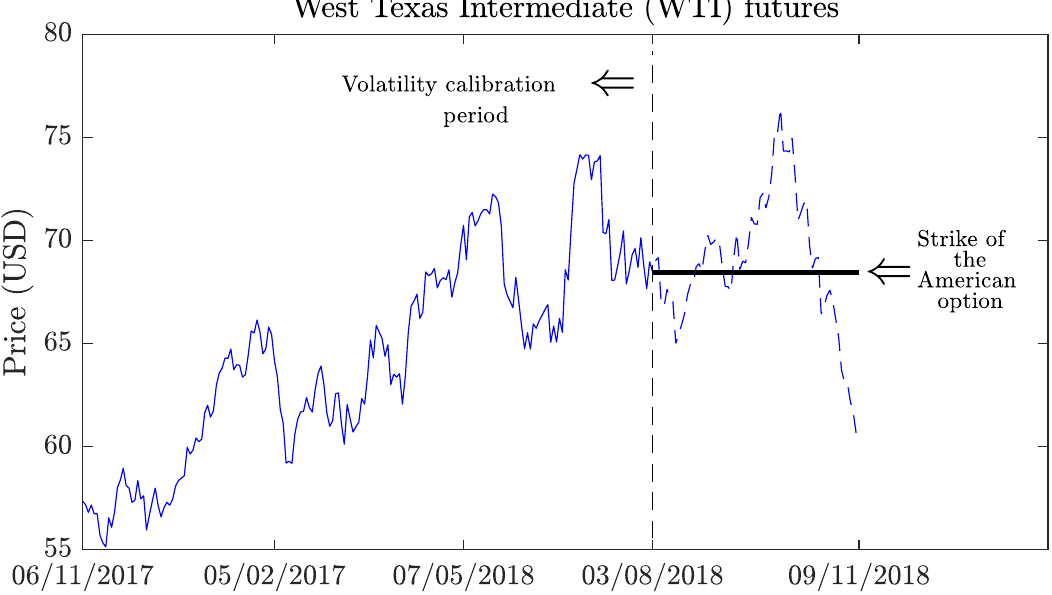
Figure 9. Daily closing prices of the West Texas Intermediate crude oil futures contracts. Data spans from 6.11.2017 to 9.11.2018. Vertical dashed line indicates the end of volatility calibration period. Option prices are calculated based on the volatility and the asset’s price on